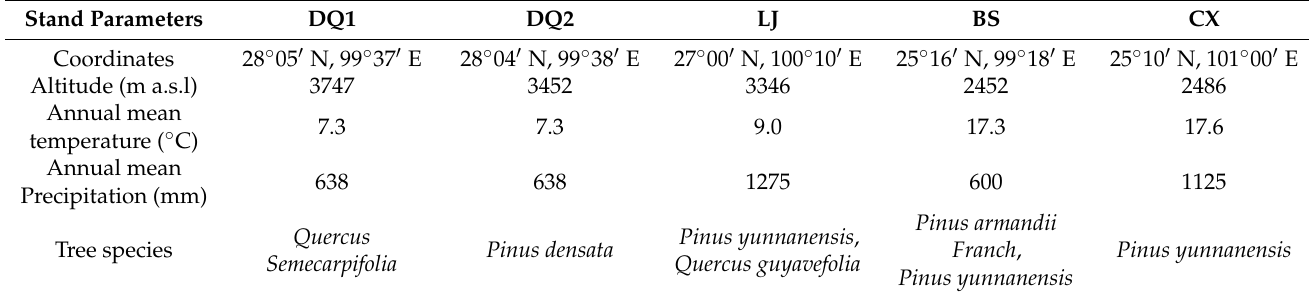
Table 1. Site and stand characteristics of the study sites Deqing (DQ1, DQ2), Lijing (LJ), Baoshan (BS) and Chuxiong (CX). Stand Parameters DQ1 DQ2